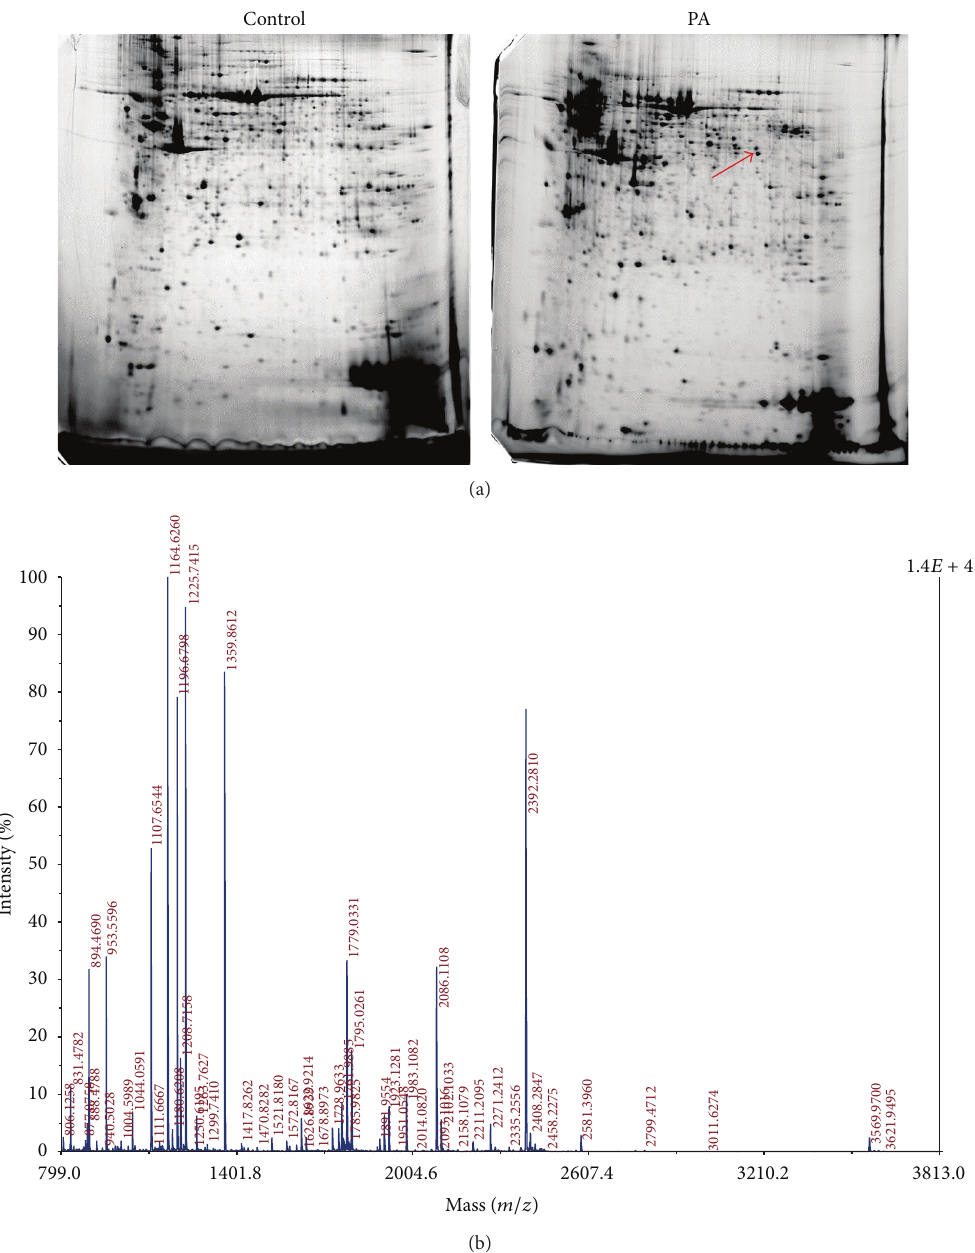
Figure 2: Proteomic analysis of lung tissue of ALI rat model. (a) Representative 2-DE gel images of lung tissues from control rats (left) and P. aeruginosa -infection induced ALI (right). Arrow indicates the spot of PRDX1. (b) A typical MALDI-MS spectrum of spot gi | 16923958 from the 2-DE map. The MS spectrum of the peptide mixture was obtained from a typical in-gel digestion of the 2-DE separated